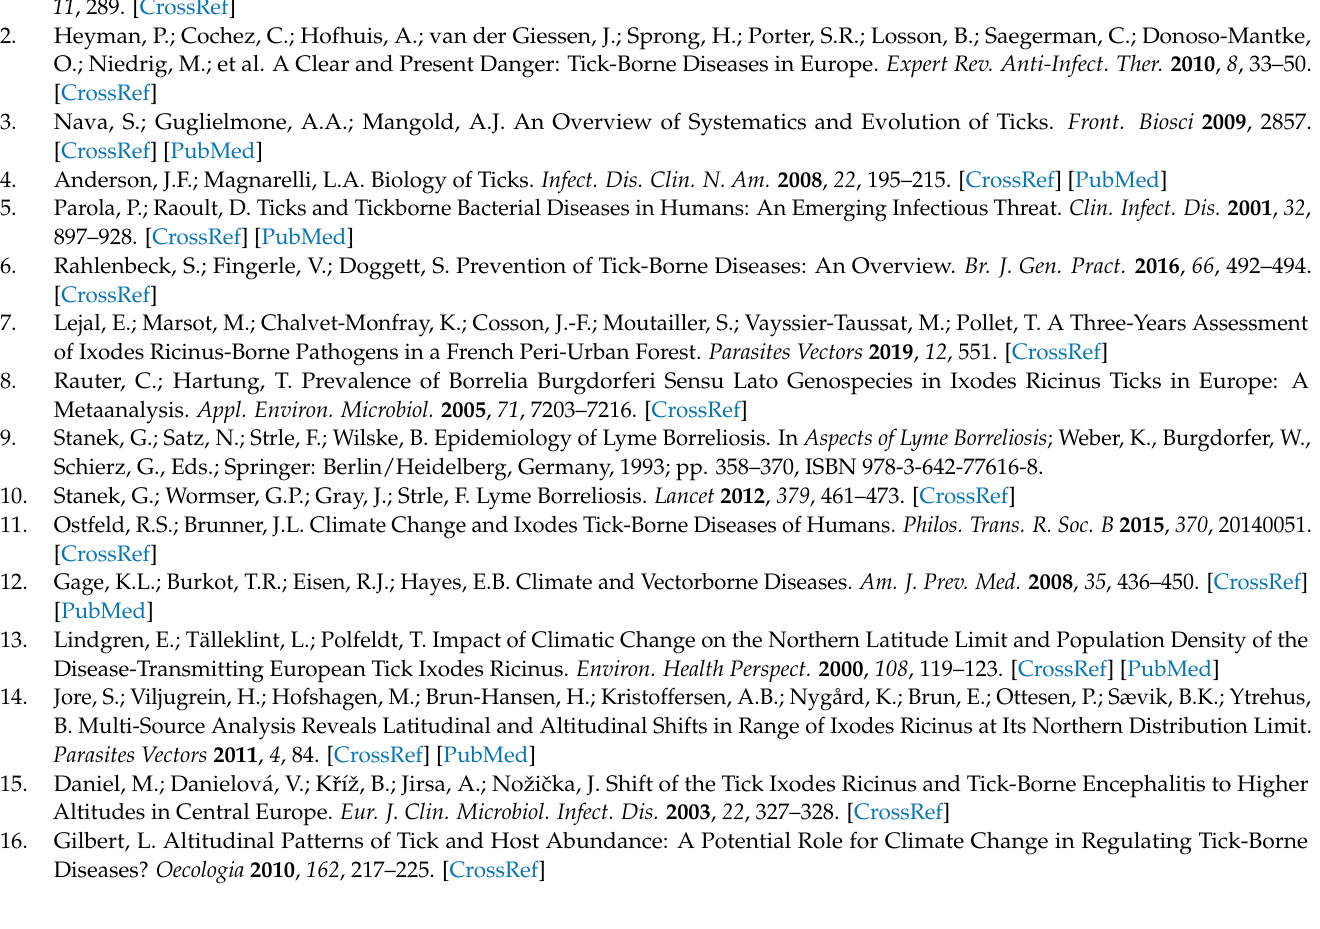
indicates a positive correlation above threshold value +0.6 and red indicates a negative correlation below threshold value − 0.6, Table S2: Global Poisson regression results, test statistics of predictor variables and results of the Monte Carlo Test for Spatial Variability, Table S3: MGWR diagnostic information and summary statistics for MGWR parameter estimates, Figure S1: ART modeling